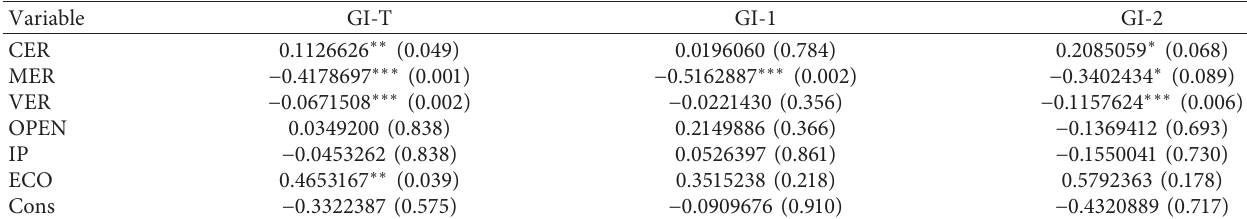
Figure 6: Curve fitting relationship between VER and GI-T. Table 9: Results of the Tobit regression